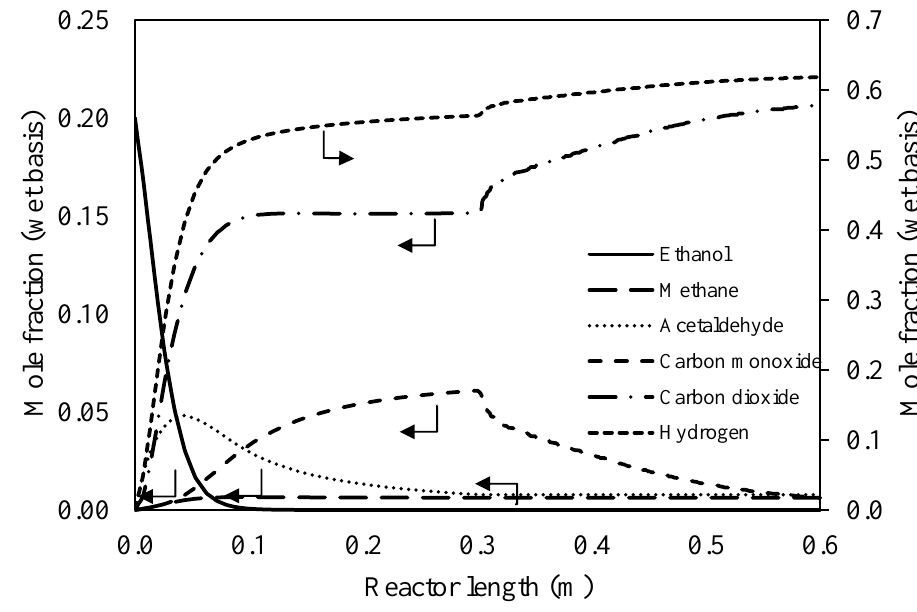
Figure 9. Mole fraction profiles at the center along CHIRS (I).